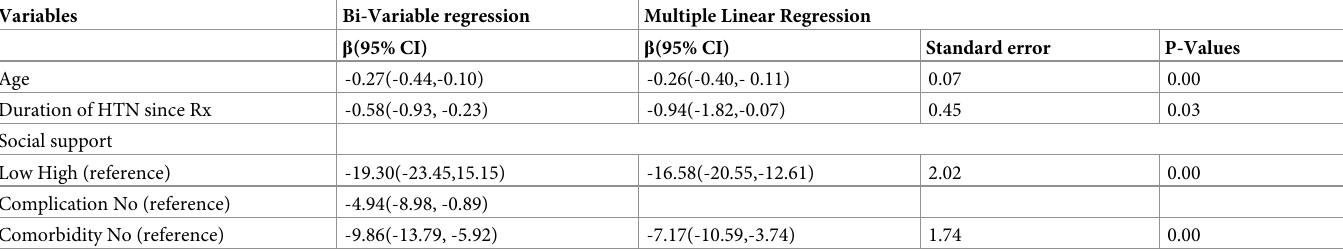
Table 5. Multivariable linear regression model on factors associated with physical domain of HRQoL among adult hypertensive patients on treatment at public health facilities in Dessie City Administration, Northeast Ethiopia, 2021 (n =